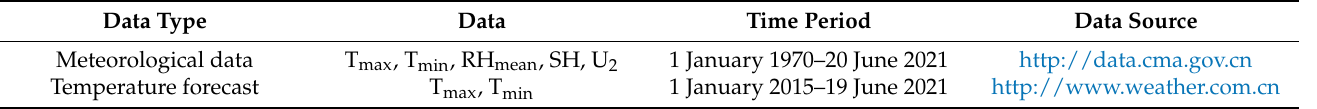
Table 2. Data used in the